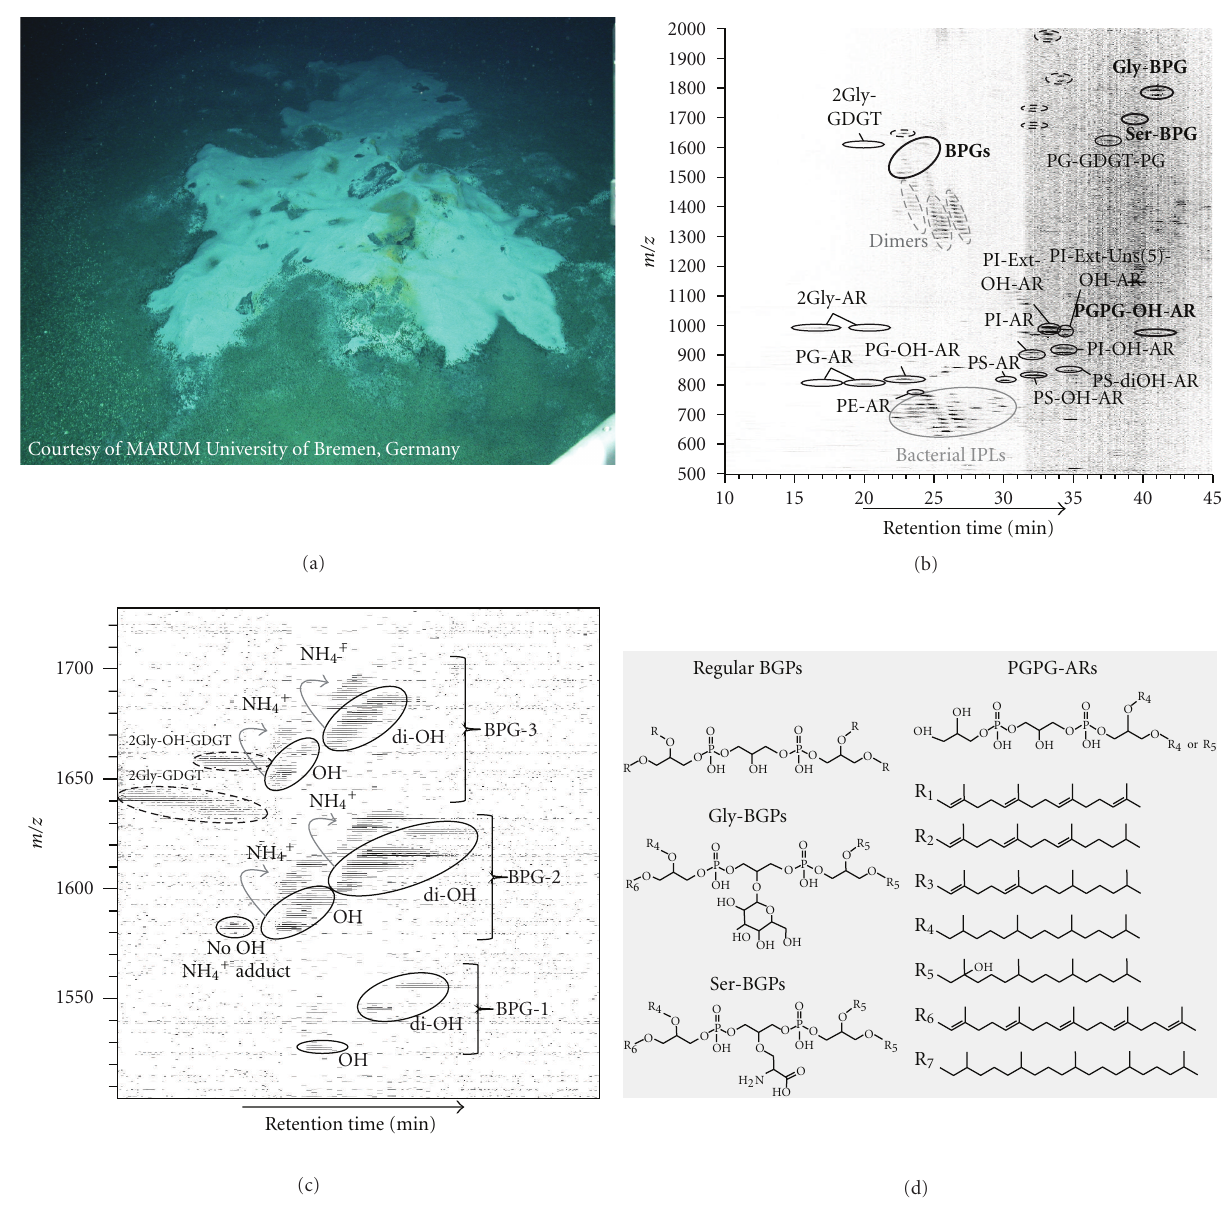
Figure 1: (a) Photography of the seafloor at site GeoB 12315 ( ∼ 1000 m water depth) during expedition M74/3 taken by the remotely operated vehicle Quest (MARUM, University of Bremen) in the continental margin o ff Pakistan; (b) density map plot showing archaeal IPLs (in black), bacterial IPLs (in gray), and novel archaeal lipids (bold) analyzed in positive mode by HPLC-ESI-IT-MS; (c) zoom in the regular BPGs area of a density map generated in positive mode HPLC-ESI-ToF-MS (BPG-1 with four C 20 , BPG-2 with three C 20 and one C 25 , and BPG-3 with two C 20 and two C 25 ); (d) structure of archaeal BPGs, other archaeal cardiolipin analogues, and PGPG-ARs. R 1 to R 7 are tentatively identified isoprenoidal moieties. Compound Abbreviations. GDGT: glycerol dibiphytanyl glycerol tetraether (C 40 – C 40 isoprenoidal chains); AR: archaeol (C 20 –C 20 isoprenoidal chains); Ext-AR: extended archaeol (C 20 –C 25 isoprenoidal chains);